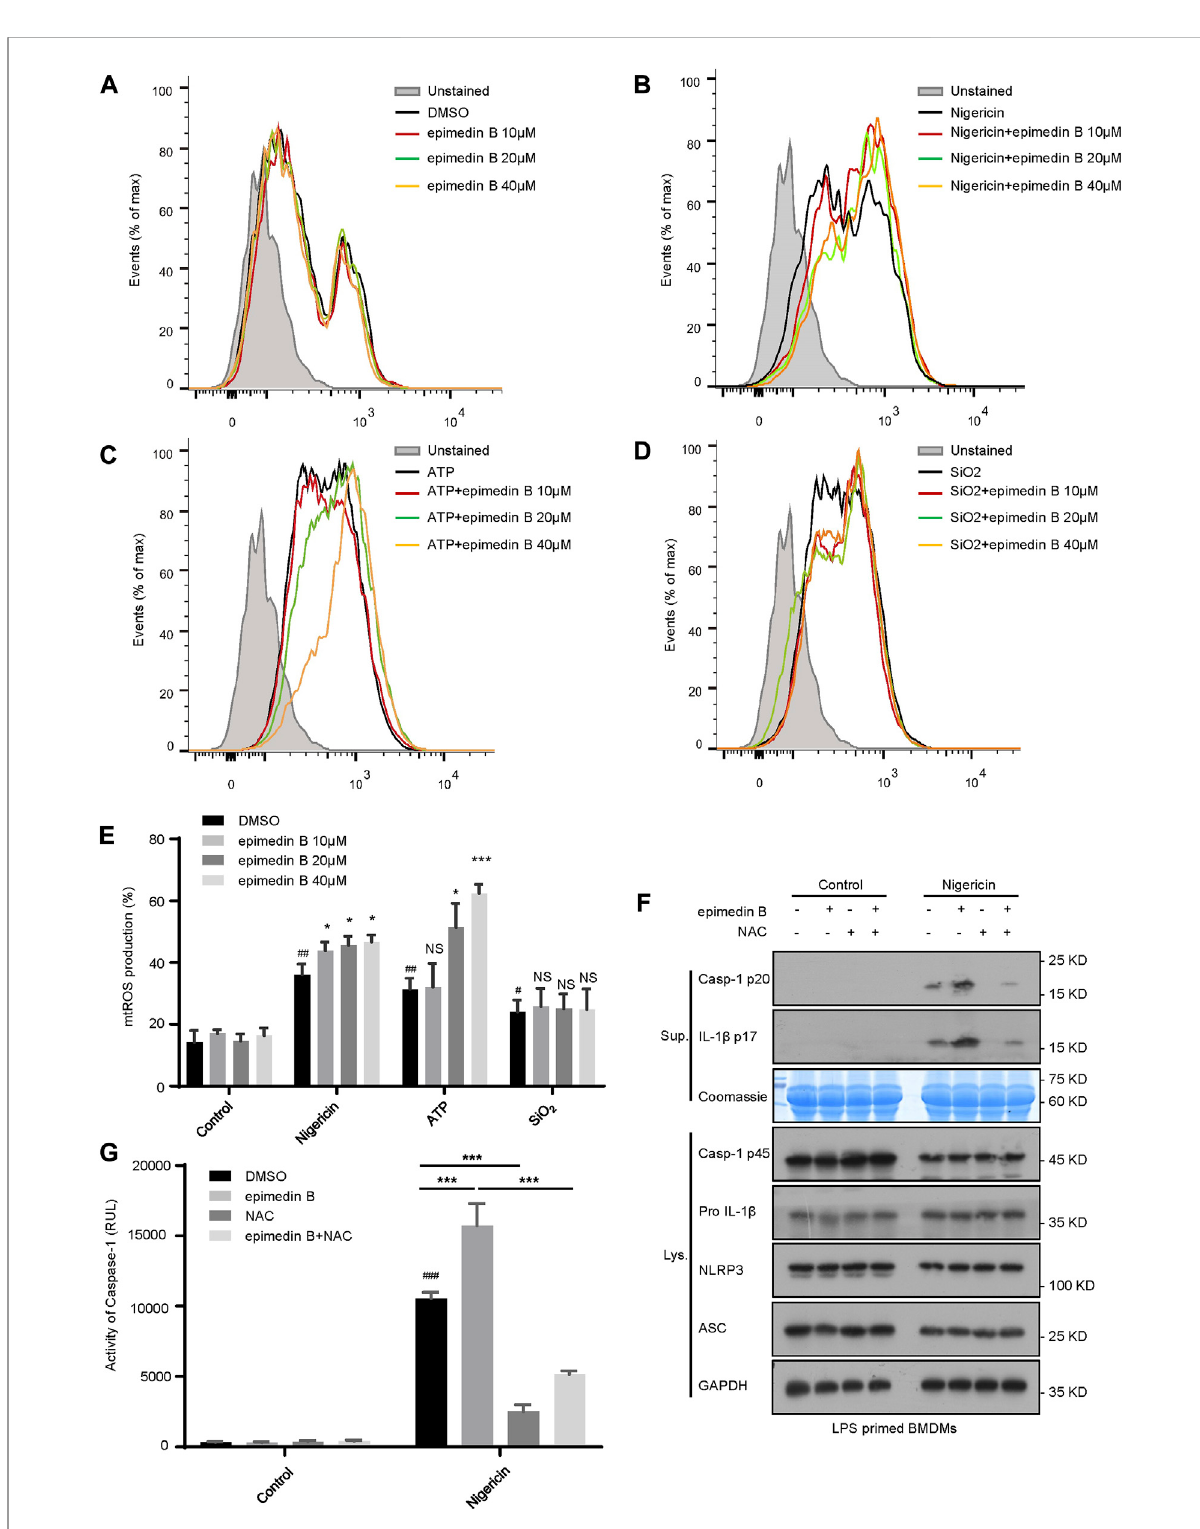
FIGURE 6 Epimedin B facilitates NLRP3 in fl ammasome activation by increasing mitochondrial reactive oxygen species (mtROS) production. (A – D) Percentage of ROS-positive cells in lipopolysaccharide (LPS)-primed bone marrow-derived macrophages (BMDMs) subjected to treatment with epimedin B that were either not stimulated (A) or stimulated with nigericin (B) , ATP (C) or SiO2 (D) , followed by staining with MitoSox. After completion of the staining and washing procedures, fl ow cytometry was conducted to determine the level of mtROS production.